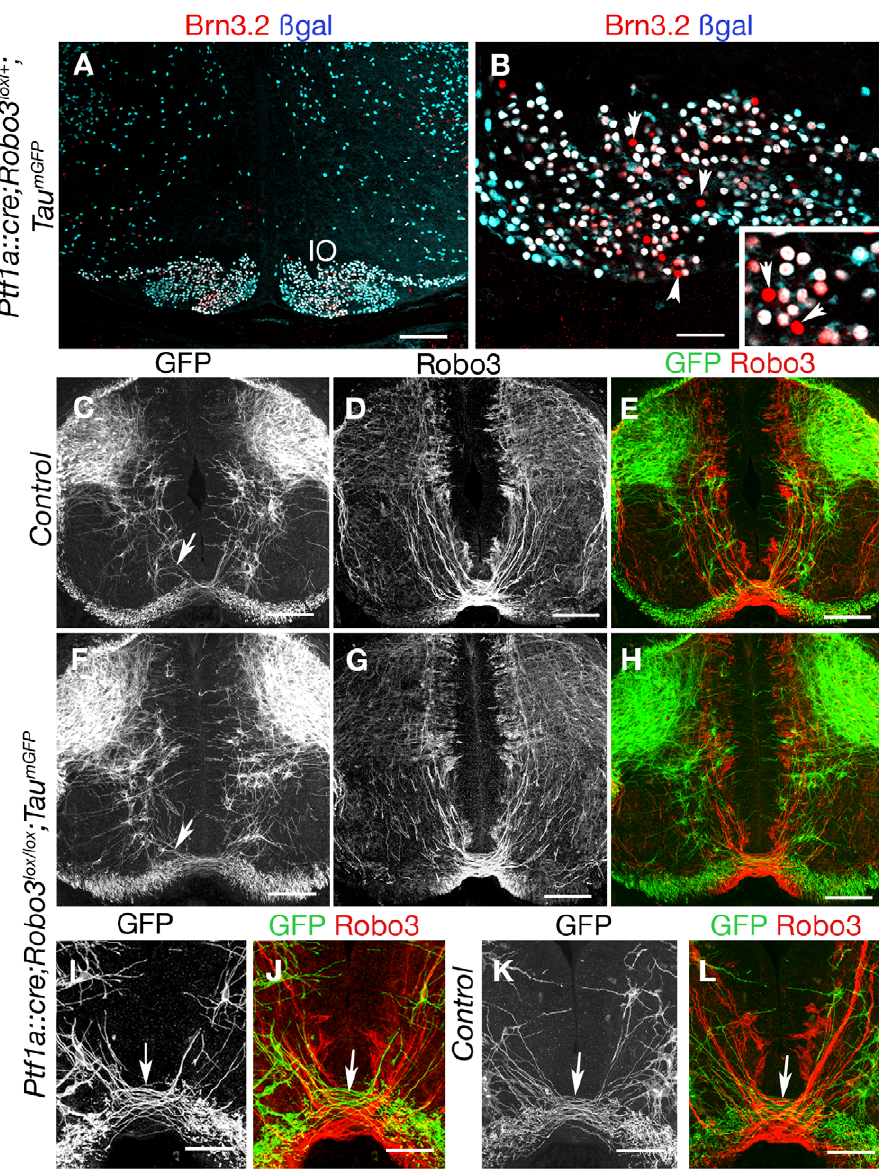
Figure 8. Analysis of Ptf1a::cre;Robo3 lox/lox ;Tau mGFP mice. (A and B) Coronal sections of the hindbrain at the level of inferior olive of E16 Ptf1a::cre;Tau mGFP embryo labeled with anti- b gal and Brn3.2 antibodies. Some Brn3.2-positive neurons in the inferior olive do not express the b gal (arrowheads and inset). (C–L) Coronal sections of the spinal cord at the level of the forelimbs in E13 Ptf1a::cre;Robo3 lox/ + ;Tau mGFP (C–E, K, and L) or Ptf1a::cre;Robo3 lox/lox ;Tau mGFP (F–H, I, and J) embryos labeled with anti-GFP and anti-Robo3 antibodies. Most GFP-positive axons are in the dorsal spinal cord, and only a small subset of GFP-positive axons (short arrows) cross the floor plate in Ptf1a::cre;Robo3 lox/ + ;Tau mGFP (C and K) but do not express Robo3 (E and L). This subset of GFP-positive commissural axons is still observed in Ptf1a::cre;Robo3 lox/lox ;Tau mGFP embryos (F and J). Scale bars represent 100 m m except in (B and I–L), where they indicate 50 m m.